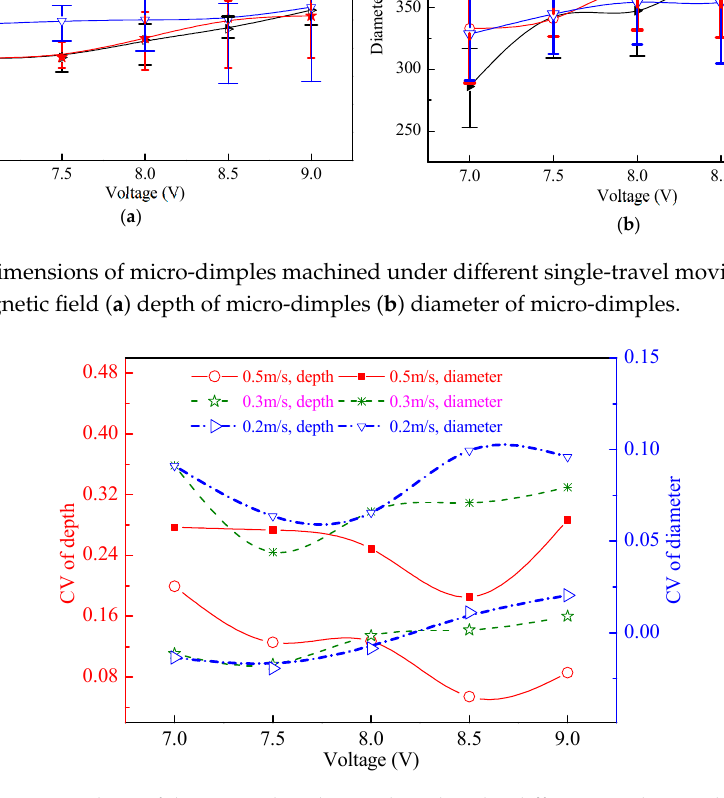
Figure 15. Dimensional CV of the micro ‐ dimples machined under different single ‐ travel moving speeds and with the magnetic field.